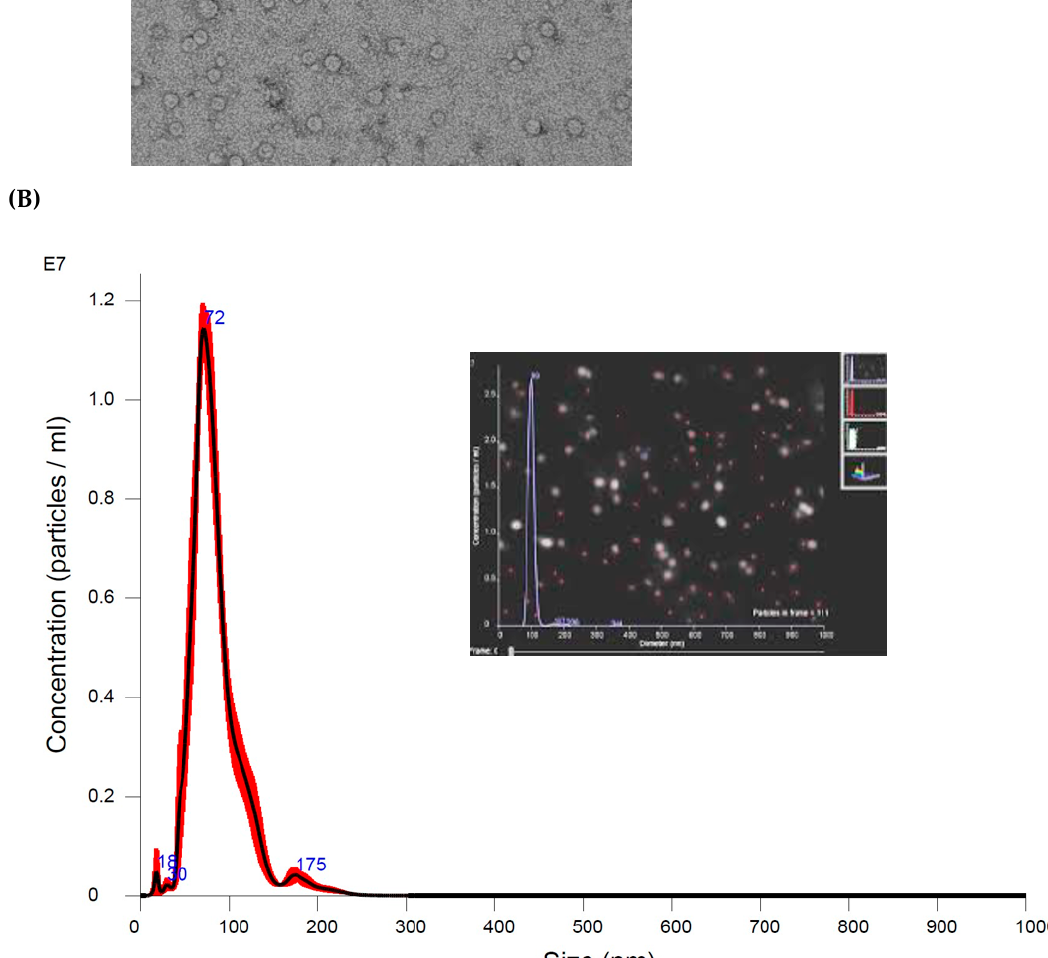
Figure A1. Characteristics of plasma extracellular vesicles (EVs). ( A ) Extracted plasma EVs were scanned by electron-microscopy. ( B ) Size and concentration of EVs were measured by NanoSight 300.